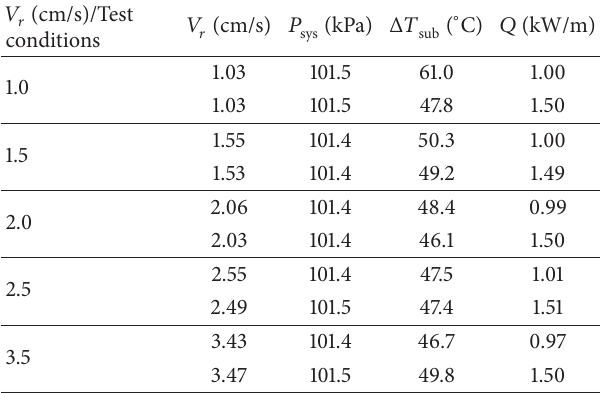
Table 1: Main test conditions of the non-blockage